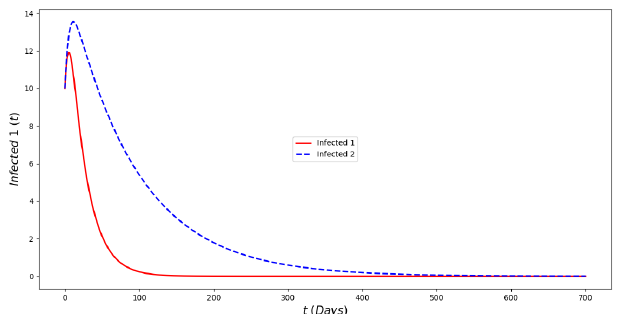
≈ 0.95 > R ≈ 0.82. The 0 1 2 . We 1